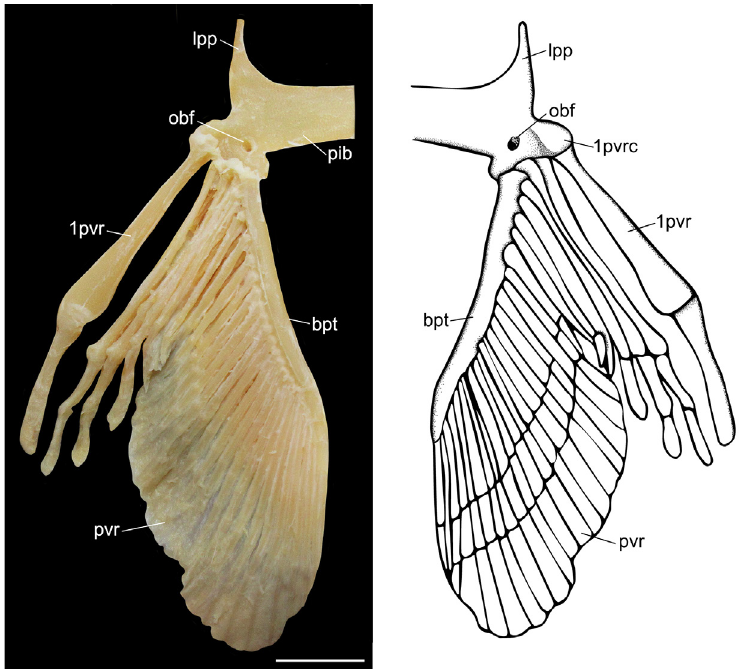
FIGURE 8 | Pelvic girdle and fin skeleton of Rioraja agassizii , MNRJ 50512, female, 505 mm TL. 1pvr , first pelvic radial segment; 1pvrc , condyle for the first pelvic radial segment; bpt , basipterygium; lpp , lateral pelvic process; obf , obturator foramen; pib , pubischiadic bar; pvr , pelvic radial segments. Scale bar = 10